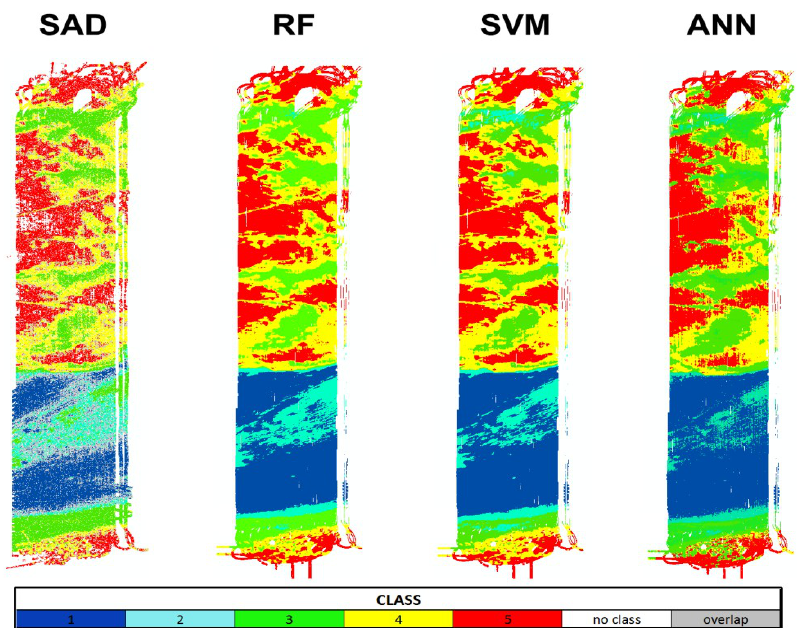
Figure 5. Supervised classification maps using the angular responses from five ground-truth locations corresponding to the cells of the iHAC as training data (Table 1). For the artificial neural network (ANN) map, all 18 ground‐truth locations were needed for training.